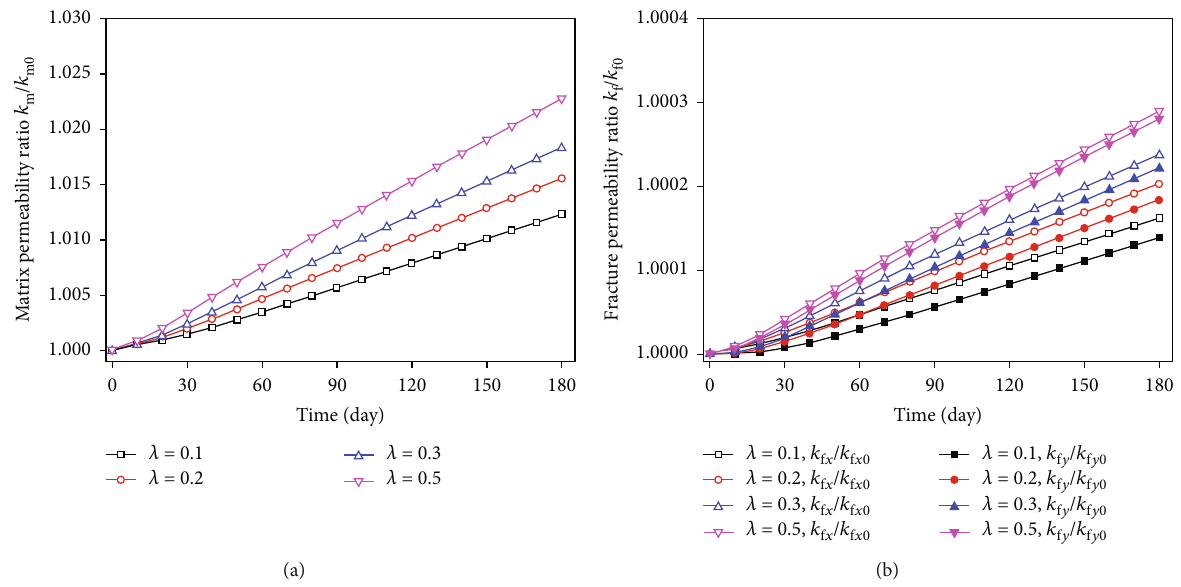
Figure 12: Matrix permeability ratio and fracture permeability ratio under di ff erent anisotropy coe ffi cients: (a) matrix permeability ratio and (b) fracture permeability ratio.